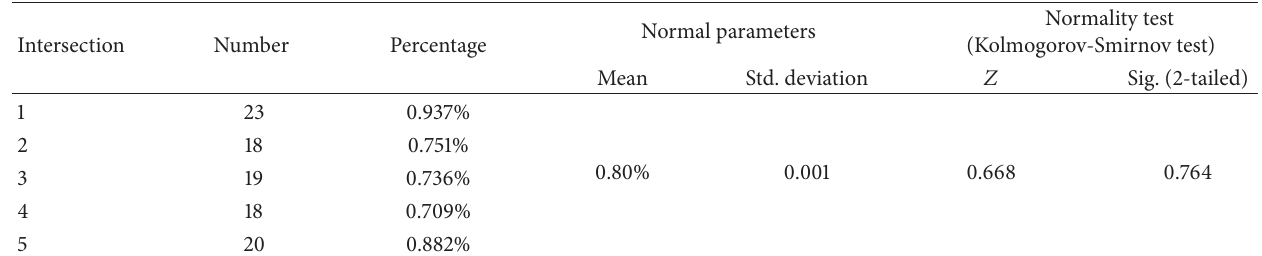
Table 10: Number of vehicles causing lane blockage.